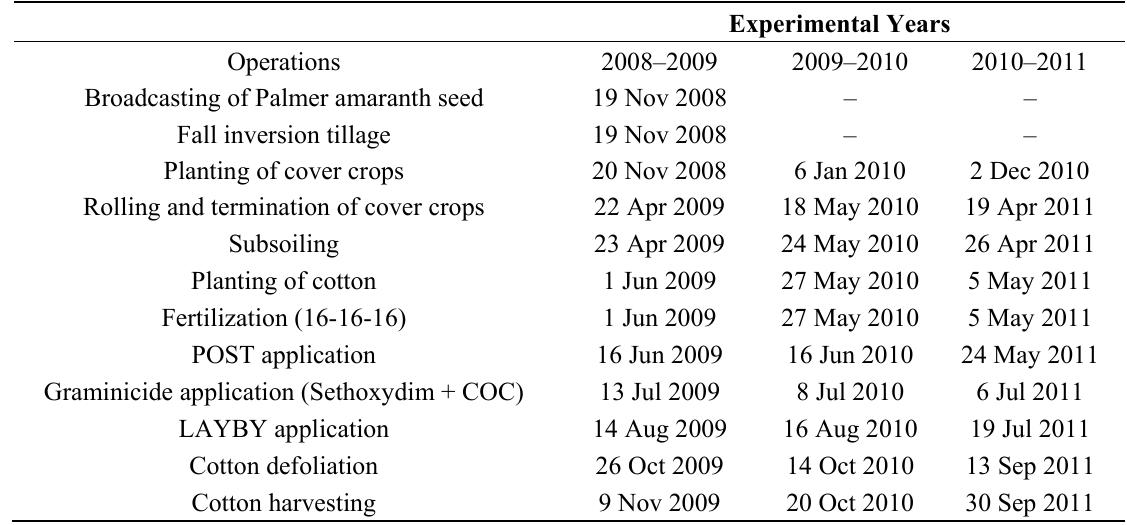
Table 1. Schedule of operations performed during the